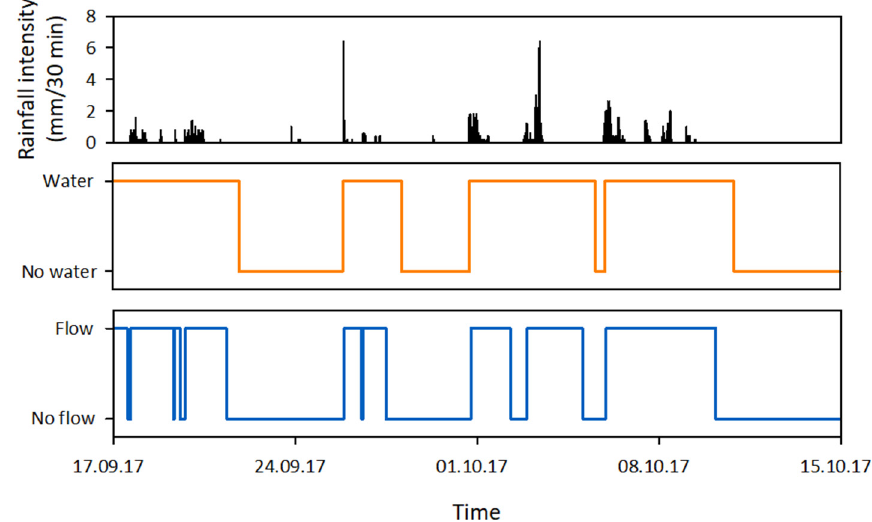
Figure 4. An example of four weeks of processed sensor data for the ER sensor and flow sensor together with the 30-minute rainfall intensity during this period.